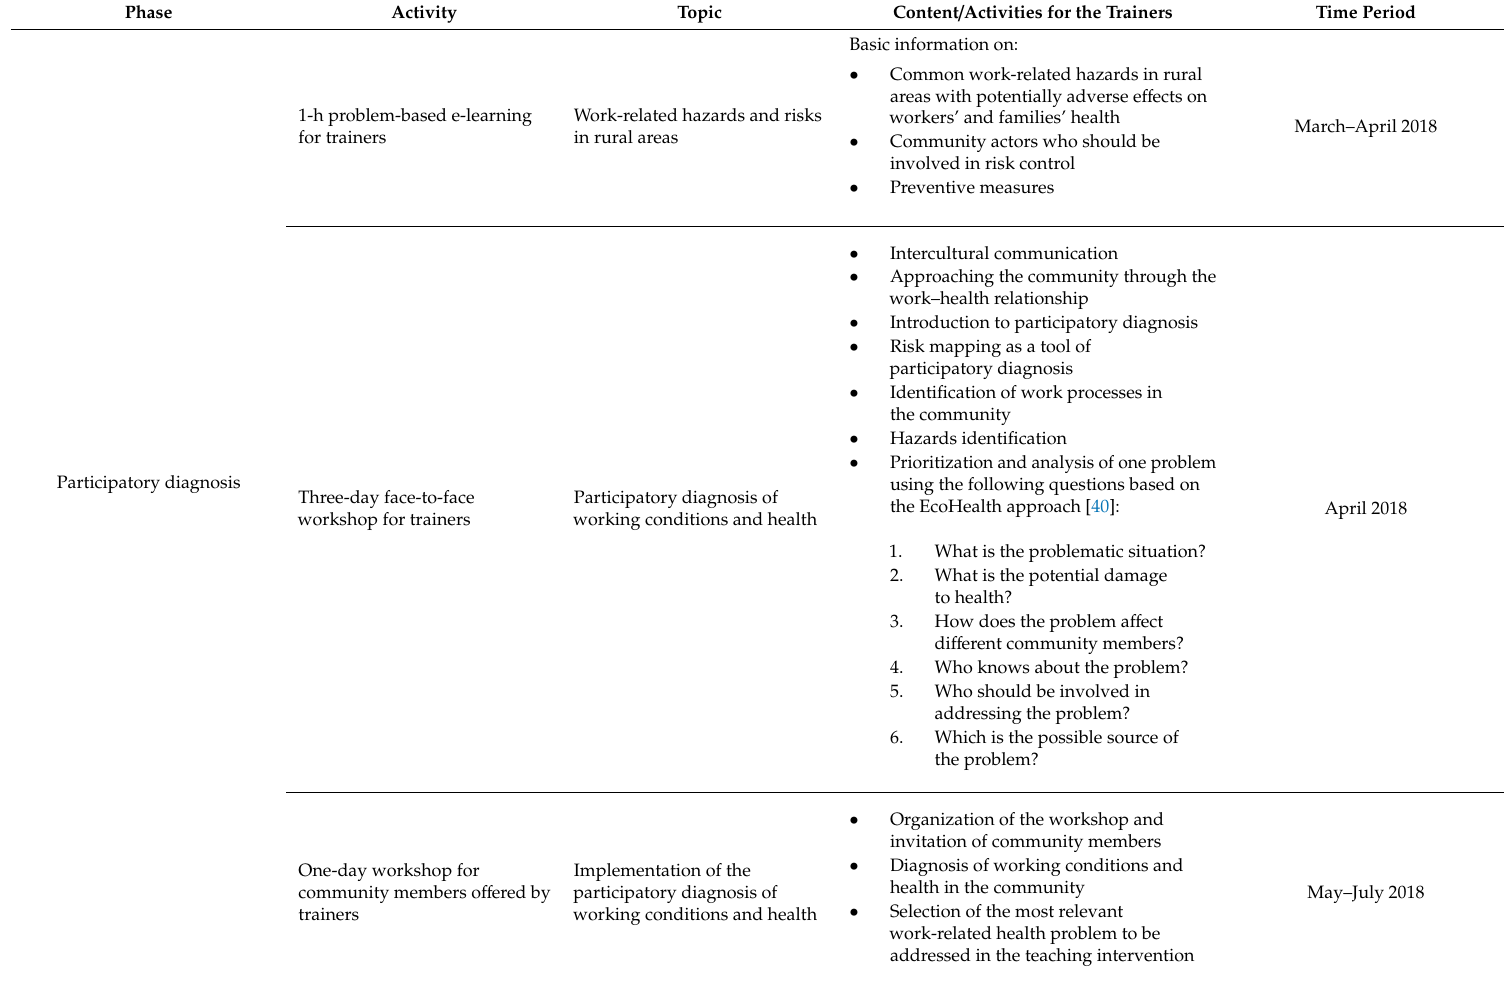
Table 1. Activities, topics, content, and schedule of the training program on occupational risk prevention in rural